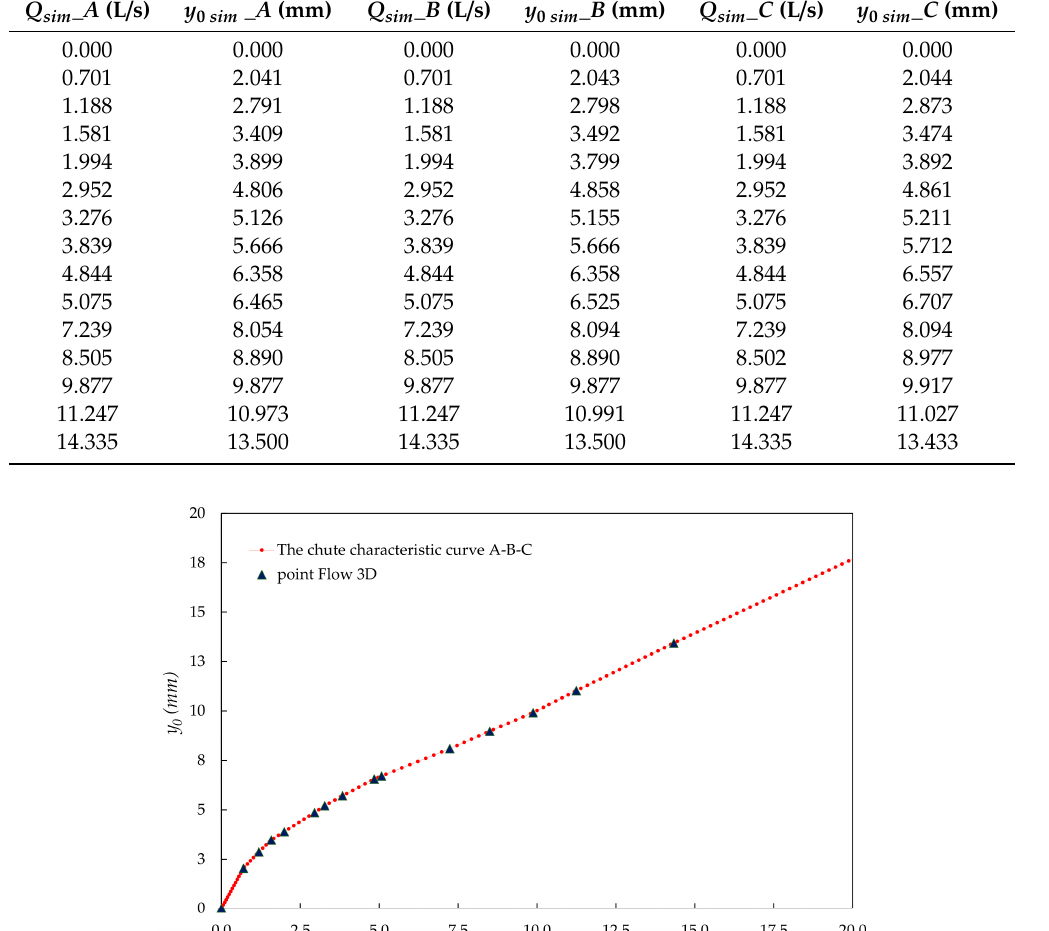
Table 6. Modeled points ( Q sim , y 0 sim ), to draw the chute characteristic curves with radius 0.2 m (A), 0.3 m (B), 0.4 m (C).